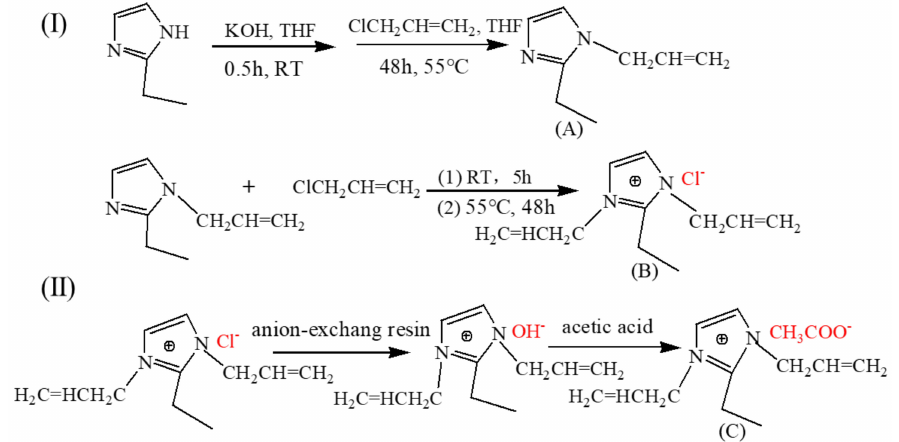
Figure 1. The ionic liquid (IL) of 1,3-diallyl-2-ethylimidazolium acetate was synthesized by a two-step method; step ( I ) Quaternization reaction; step ( II ) Anion exchange